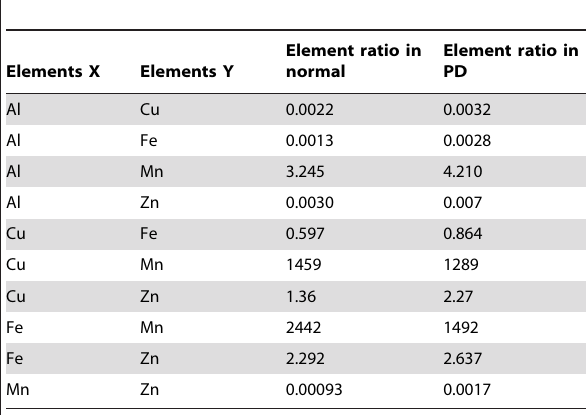
Table 2. Homeostatic imbalance of elements in comparison with